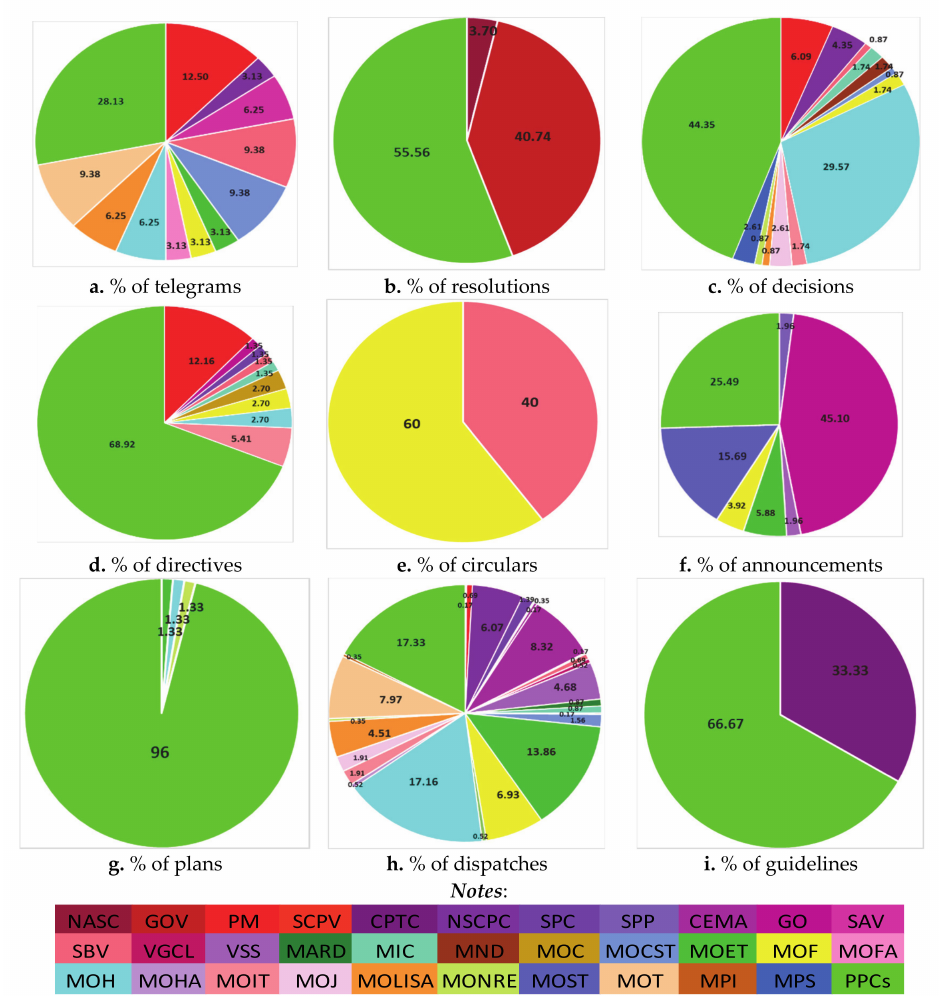
Figure 7. The proportions of COVID-19 policy forms issued by various agencies in Vietnam (as of 24 July